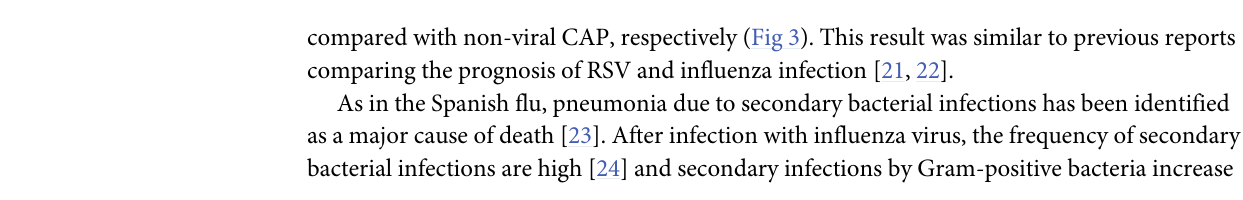
Fig 3. Forest plot of the hazard ratios with confidence intervals for 30-day all-cause mortality in relation to virus types in patients with community-acquired pneumonia compared with virus not detected.